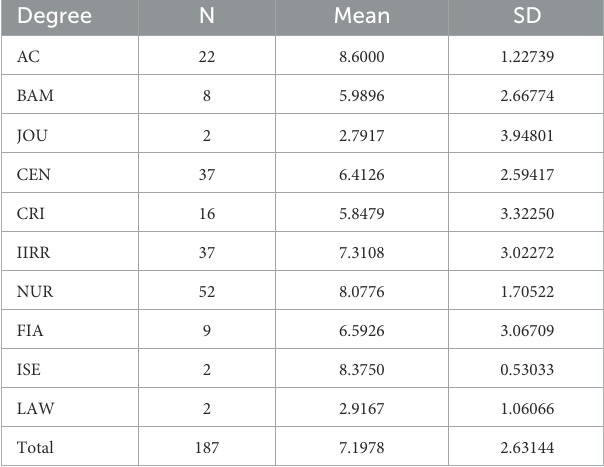
TABLE 1 Descriptive statistics results from the complete set of marks of students from all degrees included in this